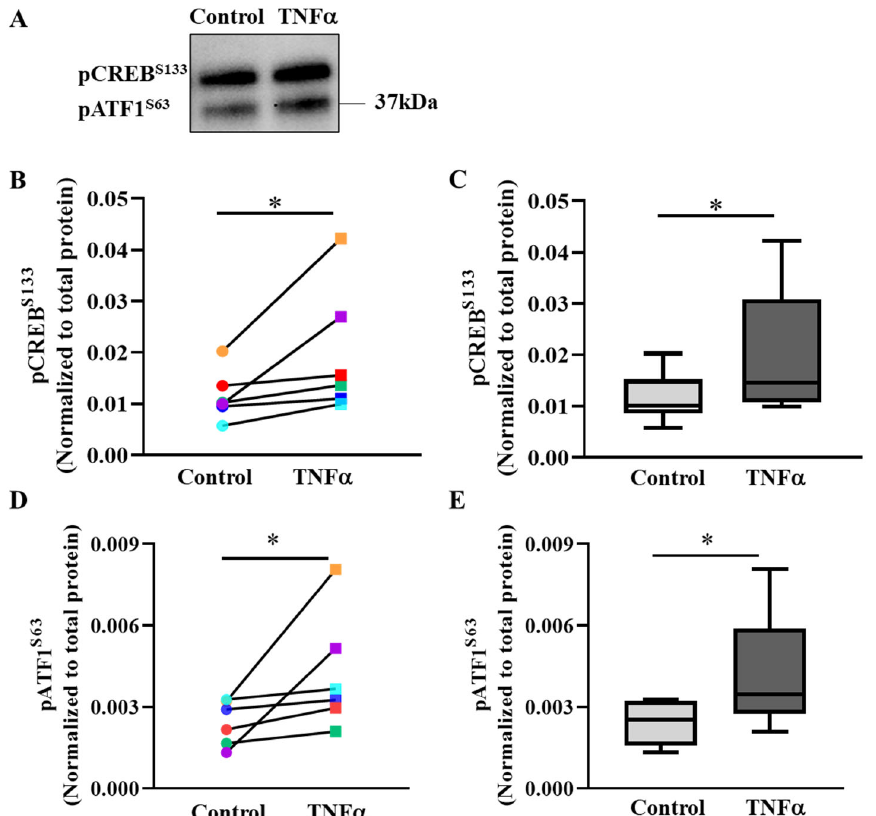
Figure 5. TNF α increases pCREB S133 and pATF1 S63 phosphorylation in hASM cells. ( A ). Representative Western blot showing the effect of exposing hASM cells to TNF α (20 ng/mL for 6 h) as compared to untreated control hASM cells on the expression of pCREB S133 and pATF1 S63 . Note that the antibody used to detect pCREB S133 also detects pATF1 S63 . The upper band was pCREB S133 and the lower band was phosphorylated pATF1 S63 . Expression of pCREB S133 and pATF1 S63 was normalized to total protein loaded in the lane. ( B ). In each of six patient hASM samples (represented by different colors), the relative expression of pCREB S133 increased in TNF α -treated (squares) compared to untreated (circles) hASM cells (* p < 0.05; n = 6). ( C ). The pCREB S133 results were summarized as box-whisker plots showing the median and minimum to maximum distribution of normalized pCREB S133 expression across the six patient samples (* p < 0.05; n = 6). ( D ). In each of six patient hASM samples (represented by different colors), the relative expression of pATF1 S63 increased in TNF α -treated (squares) compared to untreated (circles) hASM cells (* p < 0.05; n = 6). ( E ). The pATF1 S63 results were summarized as box-whisker plots showing the median and minimum to maximum distribution of normalized pATF1 S63 expression across the six patient samples. Statistical analyses on measures of pCREB S133 and pATF1 S63 were performed on n = 6 bronchial samples (patients) using a paired t -test (* p < 0.05; n = 6). Table 1. List of Primary antibodies used for Western blot and Immunocytochemistry. The antibody (Table 1) used for detecting pCREB S133 cross-reacts and detects the Primary Ab Manufacturer phosphorylated form of activating transcription factor 1 (pATF1 S63 ) (Figure 5A). After 6 h TNF α exposure, pATF1 S63 levels increased in hASM cells compared to untreated control cells from all six patients (Figure 5D; * p < 0.05, n = 6 patient samples). Figure 5E summarizes the results from all six patients, showing an ~1.7-fold increase in pATF1 S63 levels in TNF α - treated compared to untreated control hASM cells (* p < 0.05, n = 6 patient samples). Total CREB levels were not changed after TNF α treatment (Supplementary Figure